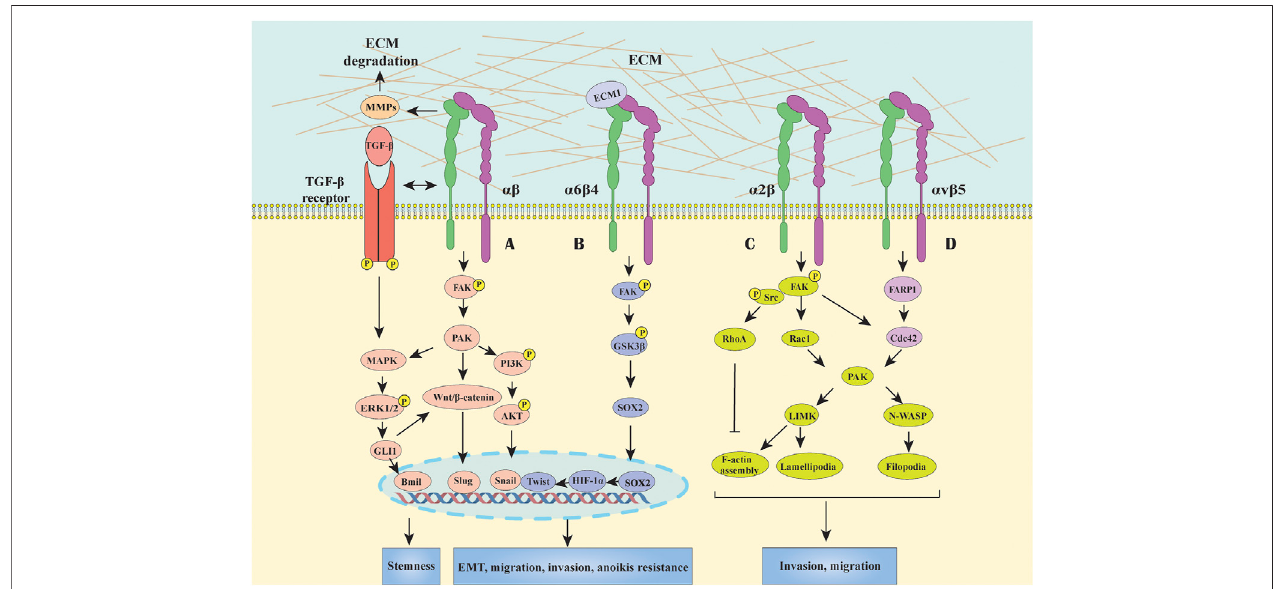
FIGURE1| Integrinsmediatedsignaltransductionpathways inGC. (A) MostintegrinsinitiateFAK-generatedsignaling,including MAPK/ERK, PI3K/AKTand Wnt/ β -catenin pathways to participate in EMT, migration and invasion processes and acquire stemness and anoikis resistance. Besides, the crosstalk between TGF- β and integrin signaling also can activate downstream effectors which cooperatively modulate EMT in a cross-regulation manner in GC. (B) Integrin α 6 β 4 activate the FAK/ GSK3 β signaling pathway, inducing the expression of transcription factor of SOX2, HIF-1 α , Snail and Twist, to promote anoikis resistance and EMT activation. (C) Integrin α 2canstabilize F-actin, promote fi lopodia formationand lamellipodialprotrusion byupregulatingRhoA, Rac1, and Cdc42, thusfacilitating GCcellmigration. (D) Association of integrin α v β 5 and FARP1 can facilitate cell motility by boosting the downstream molecule Cdc42 activity.